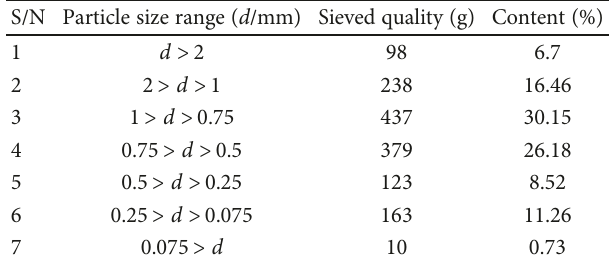
Table 5: Content of each grade of the indoor